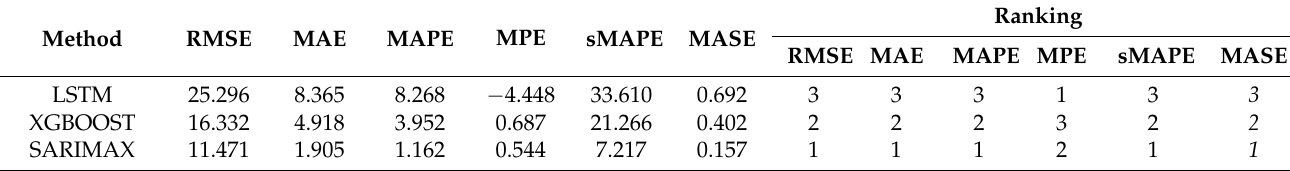
Table 5. Computational complexity for multivariate time series.